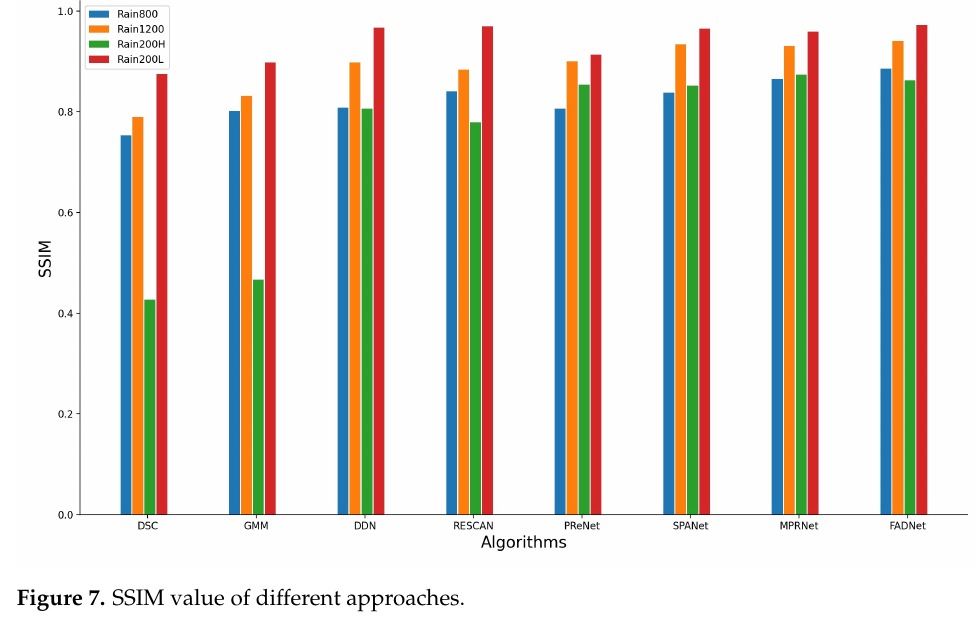
Figure 7. SSIM value of different approaches.